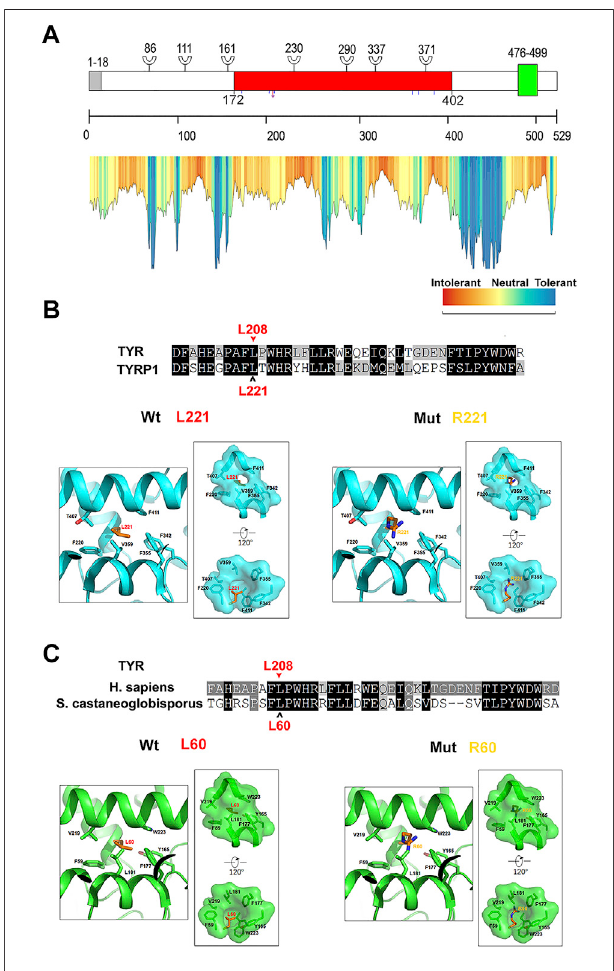
FIGURE 4 | Computational analysis of the residue where a novel variant changes in TYR (A) Schematic representation and tolerance landscape of TYR. The signal peptide (1 – 18aa) was colored in gray; the common central domain of tyrosinase (172 – 402aa) in red; transmembrane domain (476 – 499aa) in green. Branch symbols indicate putative N-linked glycosylation sites. Blue lines indicate the positions of copper-coordinating histidine. The red line plus a purple blob indicate the novel variant in this study (B) Counterpart of TYR L 208 in human TYRP1 and the effect of substitution of L208R.ThecounterpartofTYRL 208 isL 221 inhumanTYRP1.Thealignmentof amino acids of human TYR and its paralog TYRP1 shows that they are homologs to each other and the residue where a variant changes is located in theconserveddomain. Inthestructure model ofhumanTYRP1, theresidue in red is the counterpart of L 208 in human TYR, and other residues associated with it are in black. Left: structure model of wildtype TYRP1. The left square shows that L 221 is buried in the hydrophobic pocket formed by hydrophobic side-chains of surrounding residues. Residues provided by the hydrophobic surface arehighlighted, and rightrectangle,thehydrophobicsurfaceisshown in surface mode. Right: destabilization effect of leucine to arginine substitution structural analyses show that L221R causes steric hindrance and introduces changes that are incompatible with the hydrophobic environment (C) Counterpart of TYR L 208 in tyrosinase from Streptomyces castaneoglobisporus and the effect of substitution L208R. The counterpart of TYR L 208 is L 60 in tyrosinase from Streptomyces castaneoglobisporus . Based on the alignment of amino acid sequence, the residue in TYR where a novel variant changes is in red and pointed by a red arrowhead, and its counterpart is in red and pointed by a black open arrowhead. Left: structure model of ( Continued )